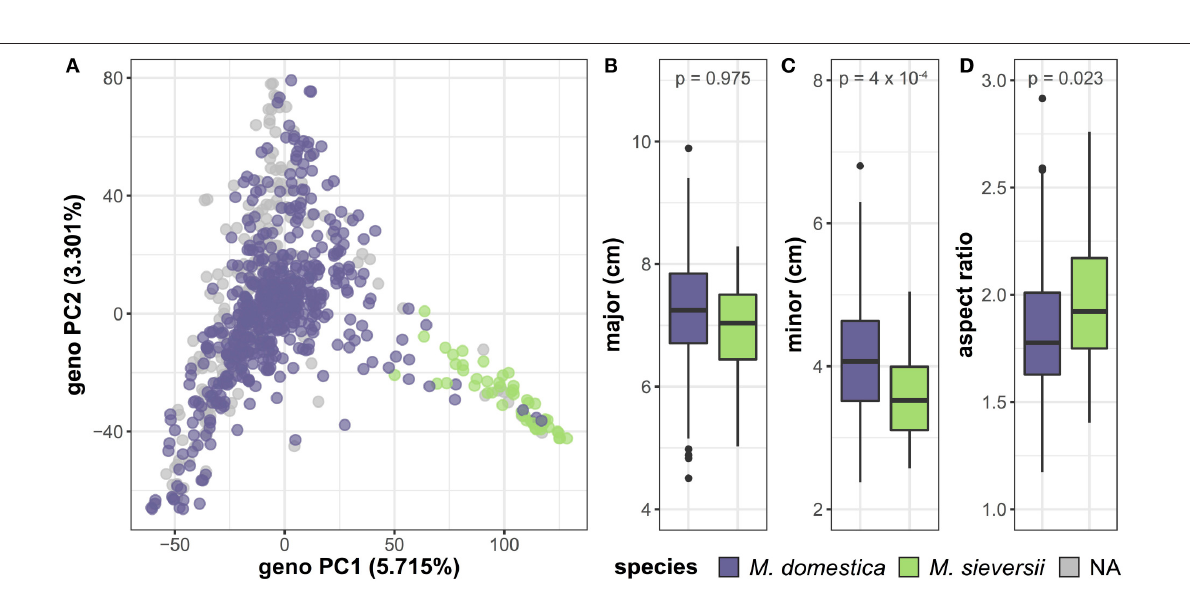
Frontiers in Plant Science | www.frontiersin.org